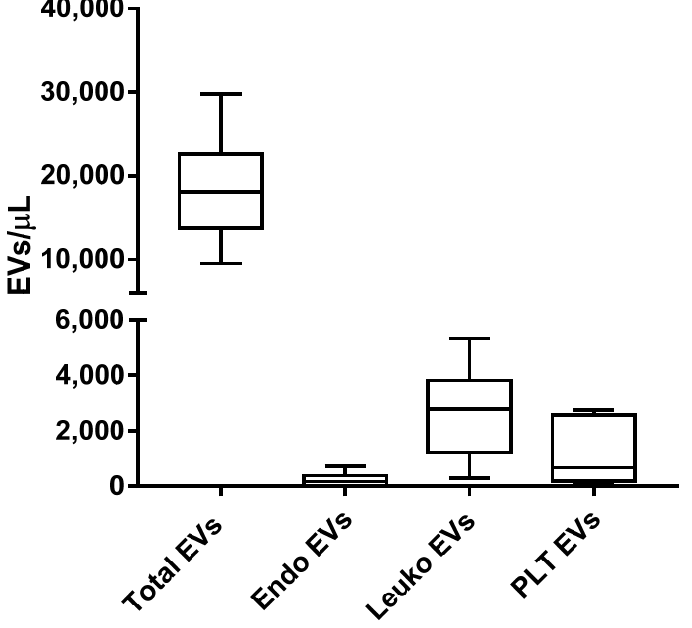
Figure 3. EV subtypes from PRP samples. The whole EV compartment, as well as EVs derived from the endothelium, leukocytes, and platelets were analyzed from the PRP of six subjects.